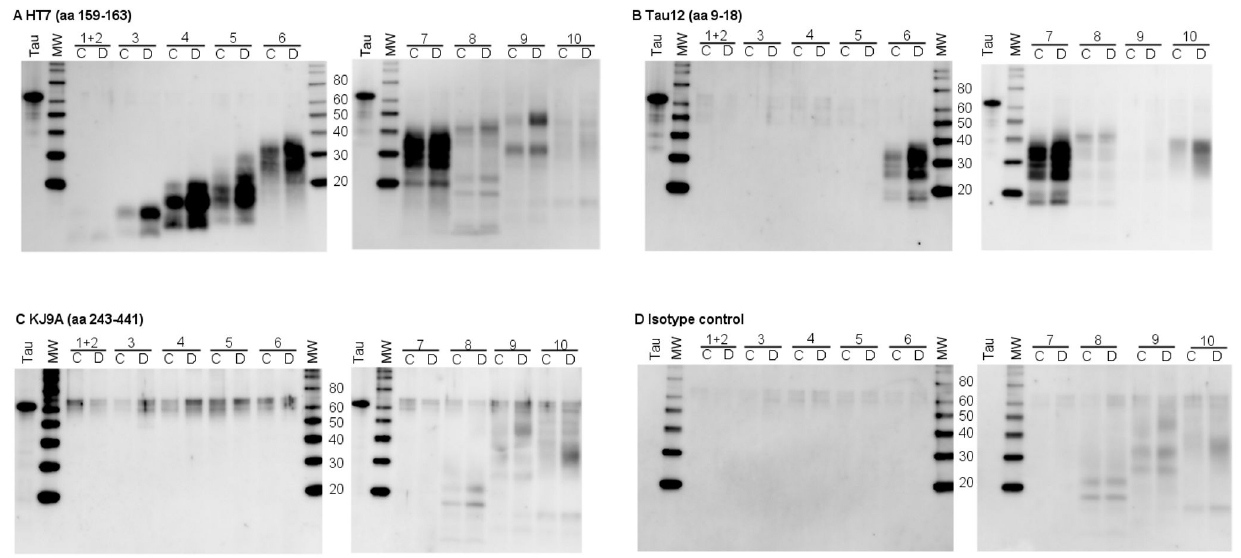
Figure 1. Detection of tau fragments in human CSF. Human control and AD CSF subjected to RP-HPLC, fractions collected and run on SDS-PAGE gels followed by western-blotting with different tau antibodies. A) HT7 (mid domain antibody). B) Tau 12 (N- terminal antibody). C) K9JA (C-terminal microtubule repeat domain antibody). D) IgG1 isotype control. On each blot, human recombinant tau441 (tau) is included in lane 1 and molecular weight markers (mw) in lane 2 followed by the HPLC fractions from 1 to 6 or HPLC fractions 7 to 11. Fractions 1 and 2 were pooled and run as a single sample, while fractions 3-10 were run as individual samples. Control CSF (C) and AD CSF (D) samples for each fraction were run side by side for